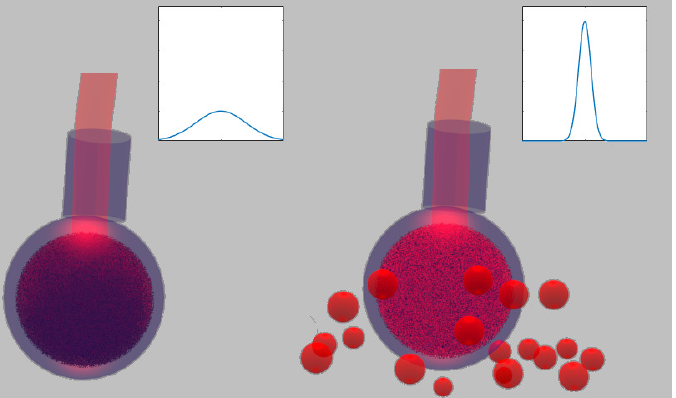
Figure 1. Working principle of the random laser sensor with external feedback. Given the same pumping energy, only once the sensor is put into contact with an external scattering sample, the random laser emission occurs. The insets represent a picture of the shape of the possible emission spectra. On the left, without the external feedback provided by external scatterers, the spectrum of the signal is broad and of low intensity, because the energy simply escapes from the sensor. On the right, the feedback allows a larger amount of light to be collected back by the fiber, whereas the spectrum becomes narrower due to the stimulated